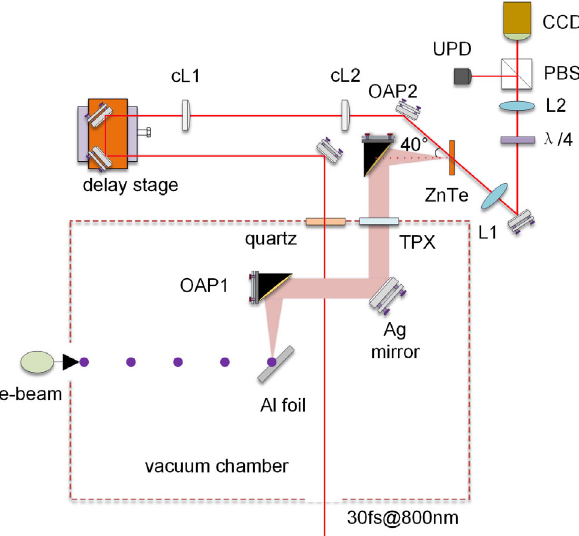
FIG. 3. Schematic of the EO spatial decoding detection. The radially polarized THz pulse incidents into the ZnTe crystal along the normal to the (110) plane and the horizontally polarized probe laser incidents into the ZnTe crystal at an angle of 40° relative to normal of the crystal surface. OAP: 90°off-axis parabolic mirror; TPX: poly(4-methyl-1-pentene); cL: cylindrical lens; UPD: ultrafast photodiode; PBS: polarized beam splitter.